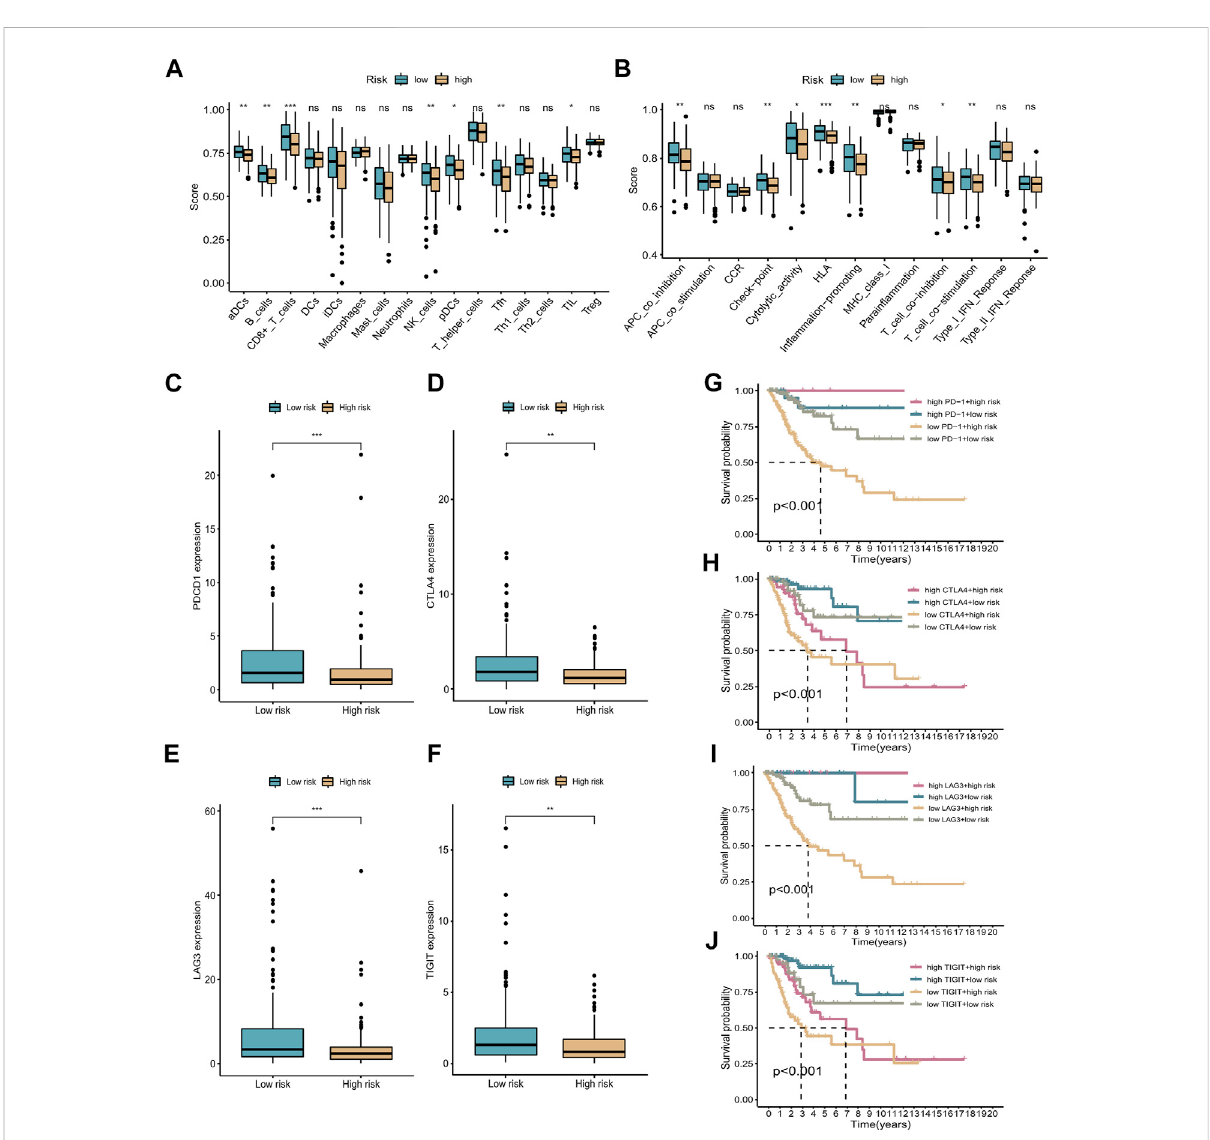
FIGURE 8 ssGSEA and immunotherapy. (A,B) Boxplots of relative levels of in fi ltration of 16 immune cells (A) and 13 immune-related pathways (B) in low- and high-risk groups. Adjusted p -values (ns, not signi fi cant; * p < 0.05, ** p < 0.01, *** p < 0.001). (C – F) Four immune checkpoints were differentially expressed between the high- and low-risk groups: PD-1, CTLA-4, LAG-3, and TIGIT. (G – J) K-M curves comparing OS rates for four patient groups strati fi ed according to the cuproptosis-related lncRNA signature and PD-1, CTLA-4, LAG-3, and TIGIT